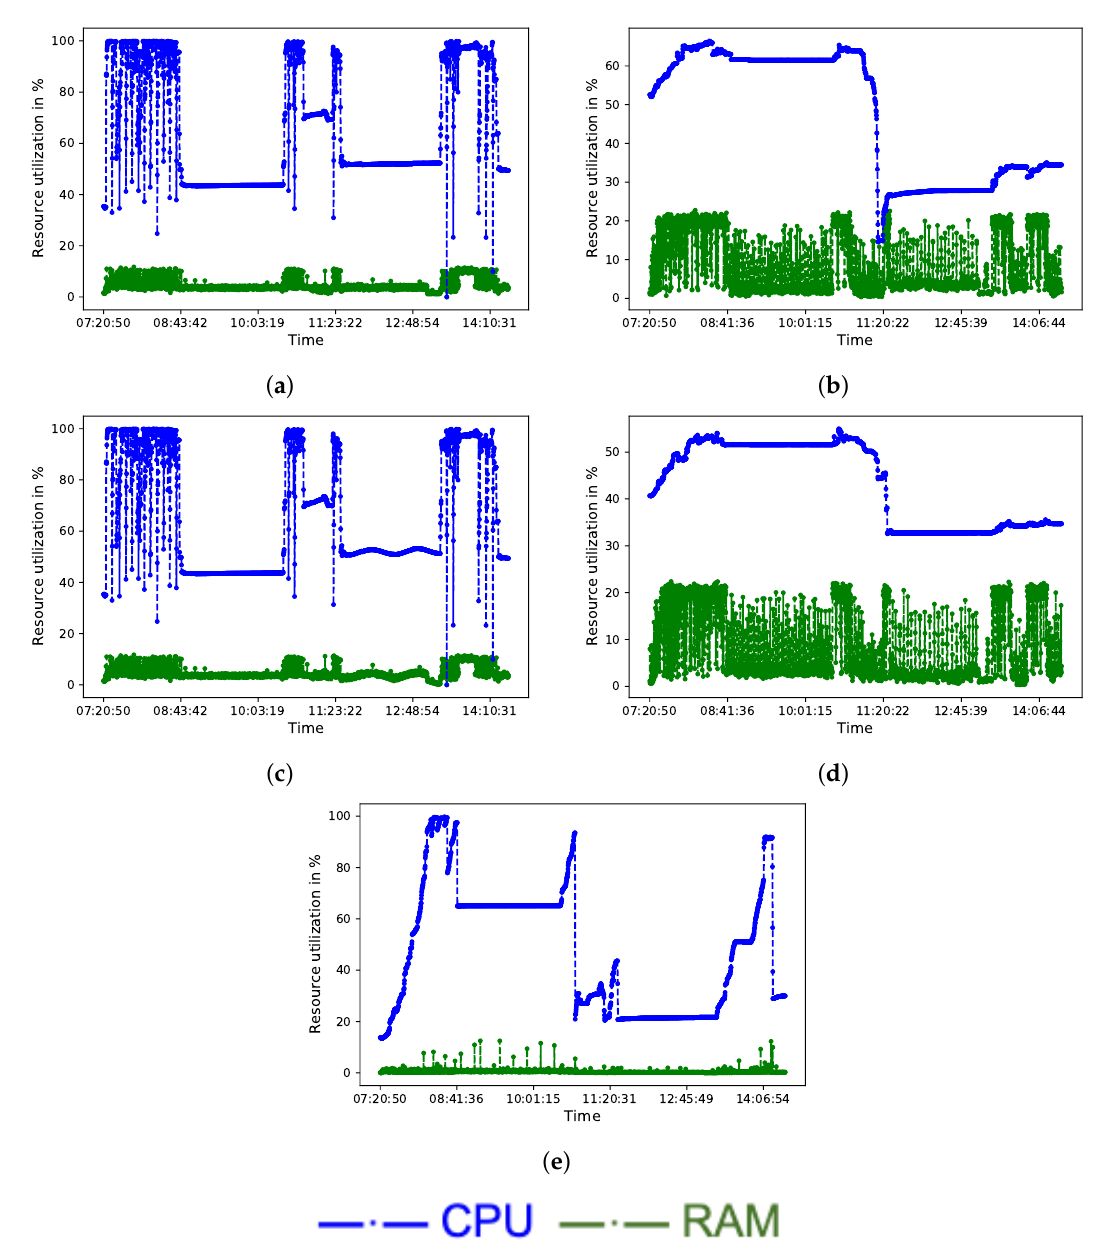
Figure 7. RAM and CPU utilization in percentage scale with respect to time: ( a ) Peer 1 Org 1; ( b ) CouchDB for Peer 1 Org 1; ( c ) Peer 1 Org 2; ( d ) D CouchDB for Peer 1 Org 2; ( e )